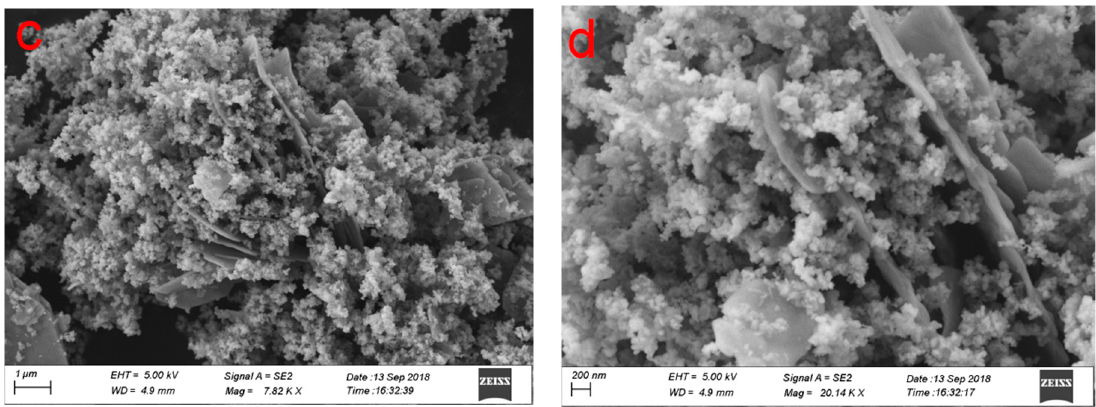
Figure 2. SEM images of as-prepared photocatalysts. ( a ) pure ZnO, ( b ) pure Bi 2 S 3 , and ( c , d ) 5%- ZnO/Bi 2 S 3 composite.